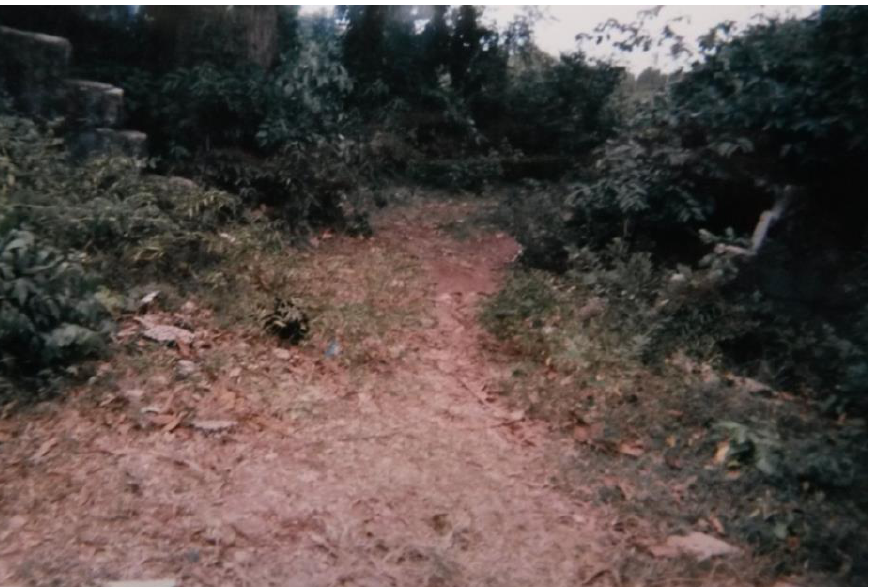
Figure 3. ‘This is a place where children get deprived of their happiness because people might sit there who take the opportunity to do a bad thing [ kitendo kibaya ] like raping you [ kukubaka ] or taking your things away [ kukupokonya ], like your phone, bag, or money ’ . (Amina, 13 years old) In photograph 3, the thirteen-year-old photographer points out the risk of sexual abuse or theft by pictu ring no more than an isolated path on the way to the Qur’anic school. The image powerfully reflects the dangerous situations an unattended child could encounter